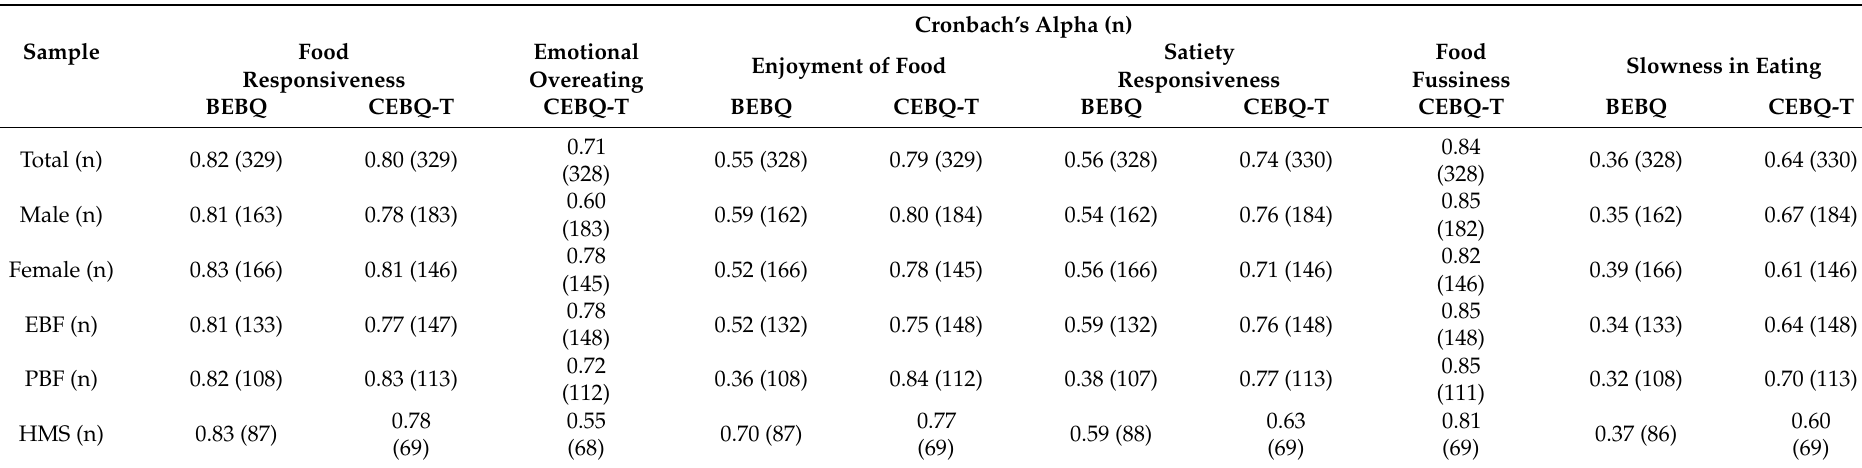
Table 3. Internal reliability (Cronbach’s alpha) by sex and feeding type of the BEBQ-Mex (n = 330) and the CEBQ-T-Mex (n = 330).